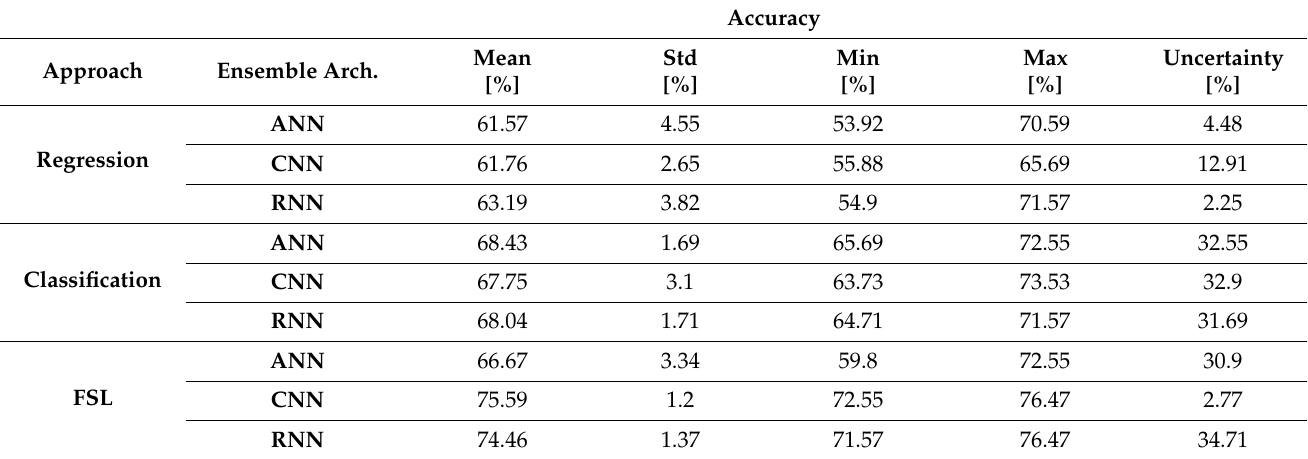
Table 5. Diagnostic performance statistics of the considered ensemble DL models and approaches.